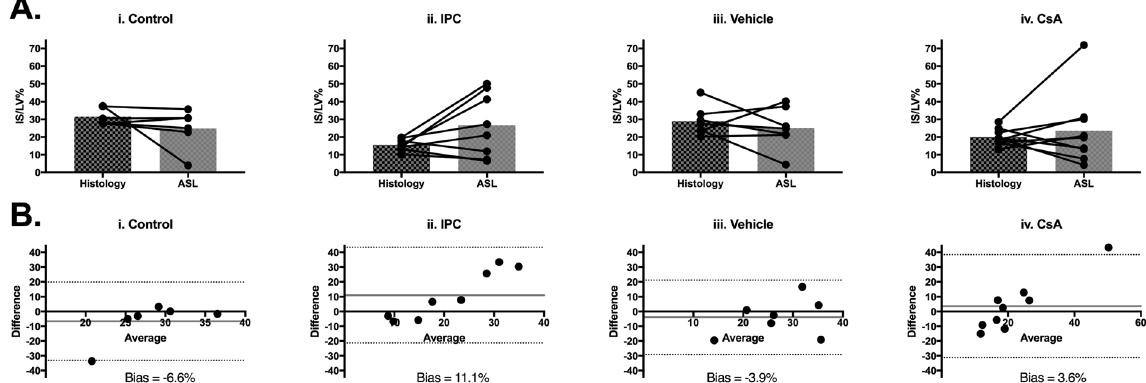
Figure 5. Validation of ASL perfusion mapping to determine in vivo MI size using a 2 SD threshold. ( A) Quantification of MI size as a fraction of left ventricle area (IS/LV%) by histological staining and ASL perfusion mapping with 2 SD threshold for individual animals in animals in control group (n = 6) (i), IPC group (n = 10) (ii), vehicle group (n = 8) (iii) and CsA group (n = 9) (iv). Mean ± standard deviation values are provided in Supp. Table 1. ( B ) Bland-Altman plots comparing histological and ASL perfusion mapping methods of estimating IS/LV% for all groups (i–iv).